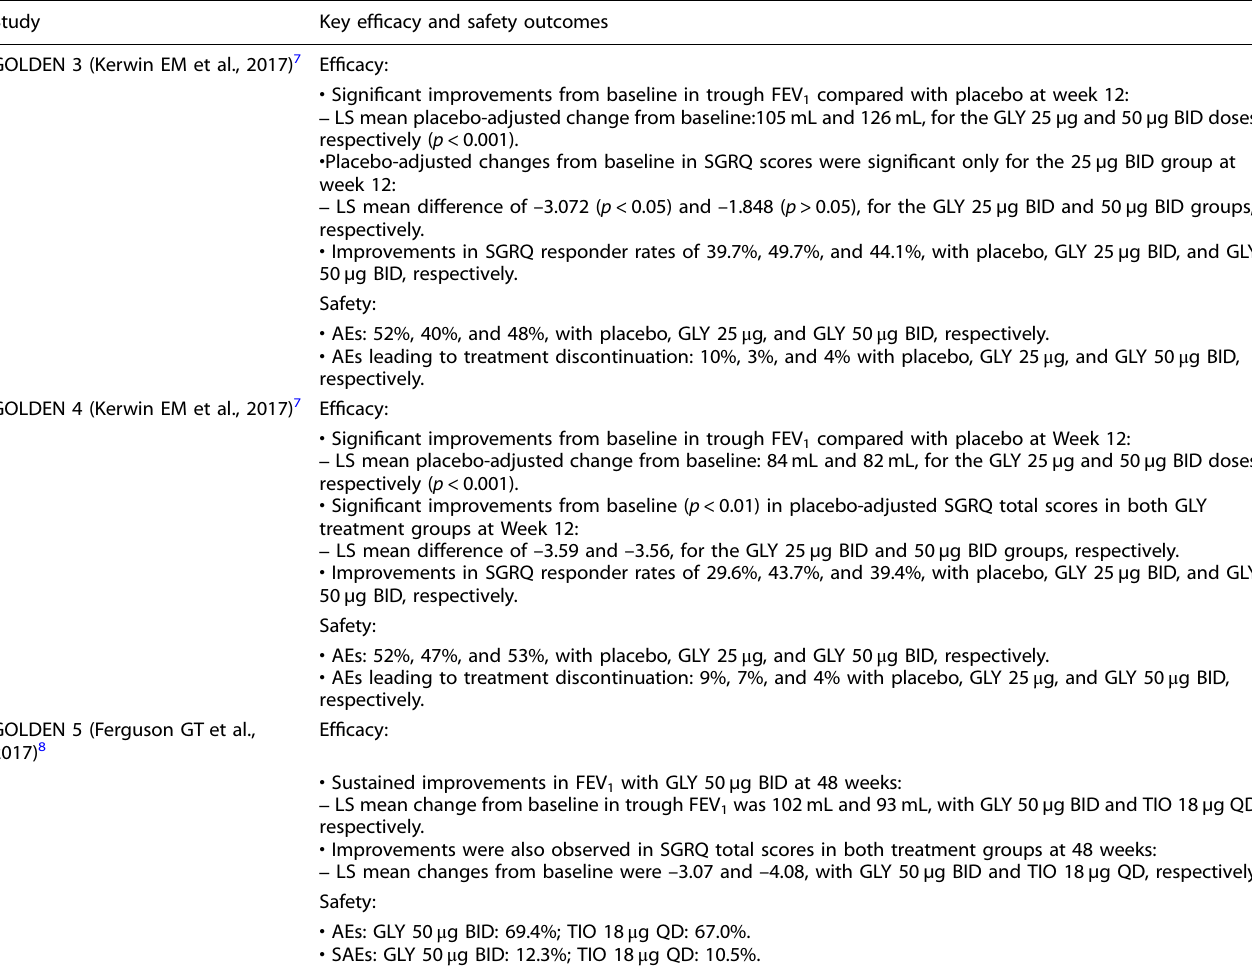
Table 1. Overview of key ef fi cacy and safety results from the GOLDEN 3, GOLDEN 4, and GOLDEN 5 Phase III studies of nebulized GLY. Study Key ef fi cacy and safety